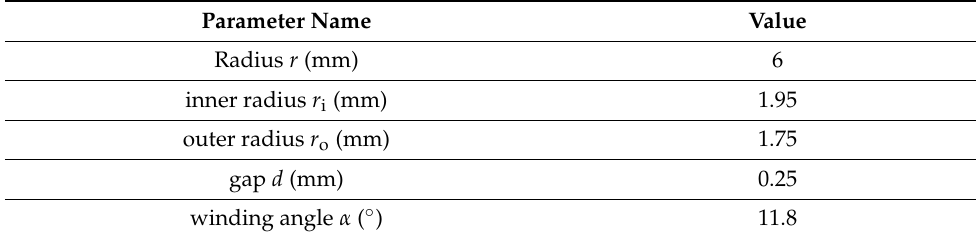
Table 1. Geometric parameters of the seven ‐ wire strand.